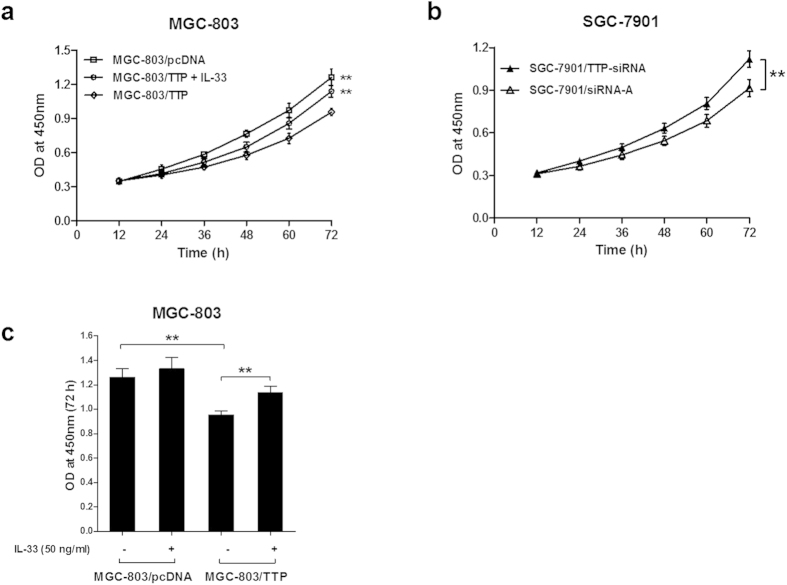
TTP suppresses cell proliferation of gastric cancer in vitro through down-regulation of IL-33.(a) CCK-8 assay was performed in MGC-803 cells at the indicated times to evaluate the effect of TTP and IL-33 on cell proliferation. (b) CCK-8 assay was performed in SGC-7901 cells to evaluate the effect of TTP on cell proliferation. (c) Addition of recombinant human IL-33 (50 ng/ml) abolished the inhibitory effect of TTP on the proliferation of MGC-803 cells. The absorbance at 450 nm was measured to assess cell viability. The data are represented as the mean ± SD. **P < 0.01.